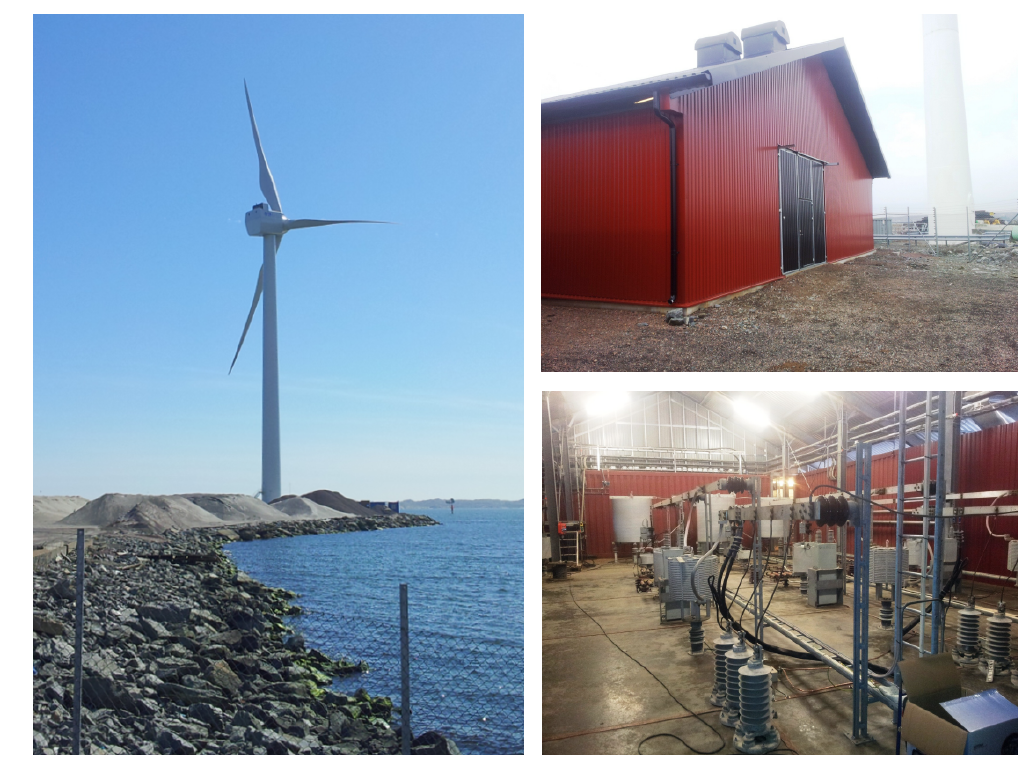
Figure 3. Gothenburg test facility, comprising the 4.1MW FPC “Big Glenn” wind turbine. The facility houses the back-to-back HVDC station and coupling inductor (back) and AC filters